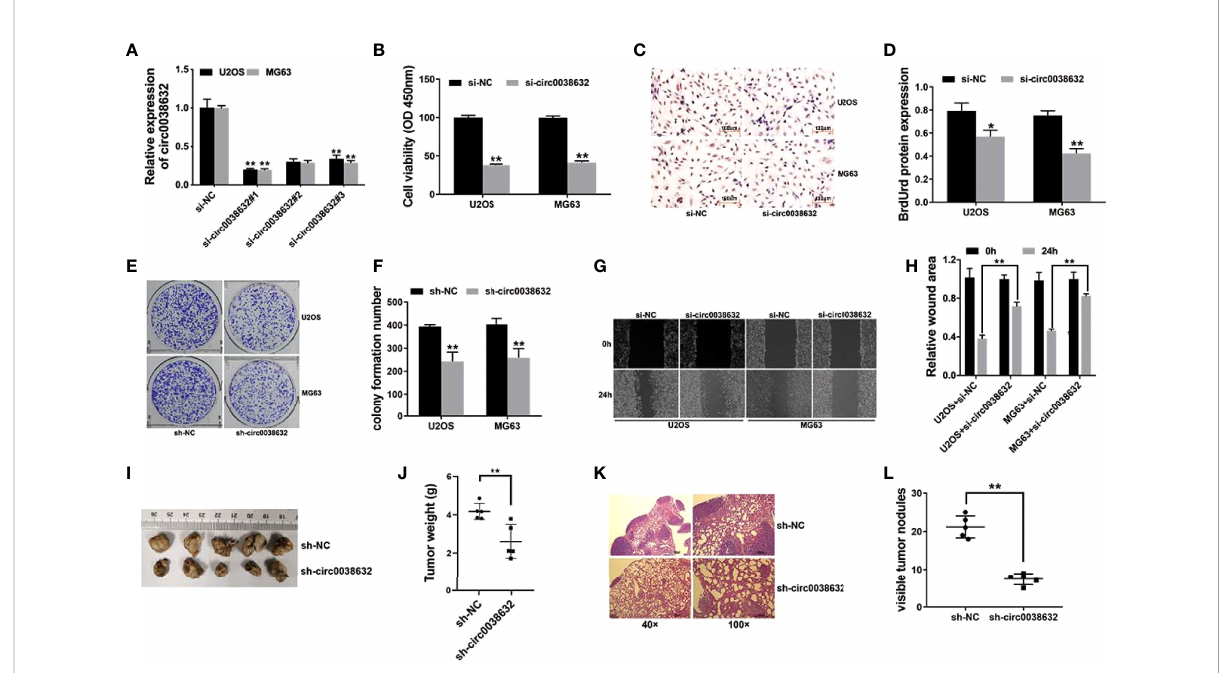
FIGURE 2 circ0038632 silencing suppresses the function of proliferation and metastasis in osteosarcoma. (A) siRNAs were used to knockdown circ0038632 expression in osteosarcoma cells. (B) Cell proliferation ability was evaluated through CCK-8 assay. (C) BrdUrd incorporation was assessed by immunohistochemistry (IHC) to evaluate cell proliferation after transfection. (D) Statistical chart of BrdUrd total gray value. (E) The pictures of clone formation from osteosarcoma cells were showed. (F) Statistical chart of cloning derived from osteosarcoma cells. (G) Migration ability was assessed by wound healing assay. (H) Statistical chart of wound closure. (I) Mouse xenograft models were established to evaluate circ0038632 intravital function. (J) Statistical chart of tumor weights. (K) The pictures of lung metastatic nodules with HE staining were showed. (L) Statistical chart of metastatic nodules. * P < 0.05 and ** P <